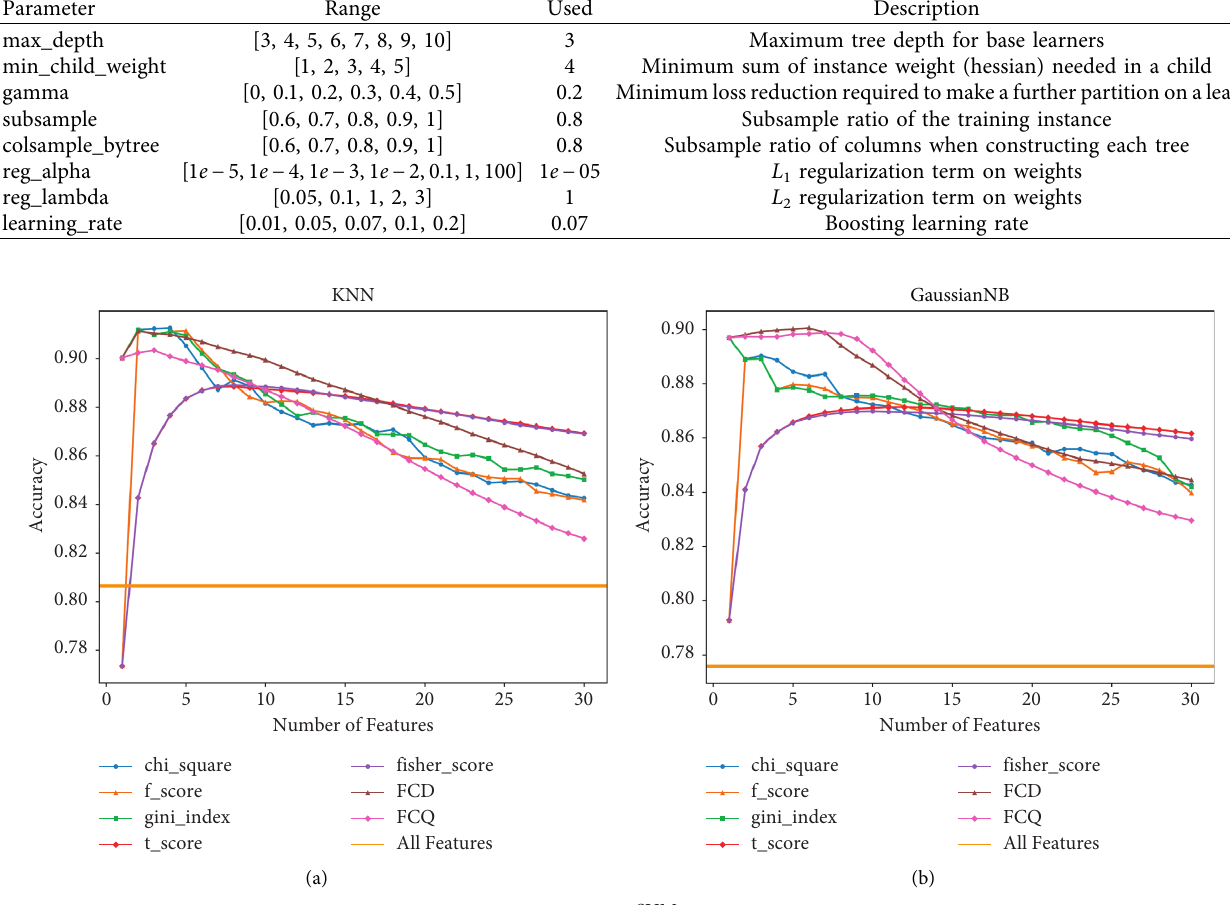
Table 3: Parameter setting by grid search for XGBoost.